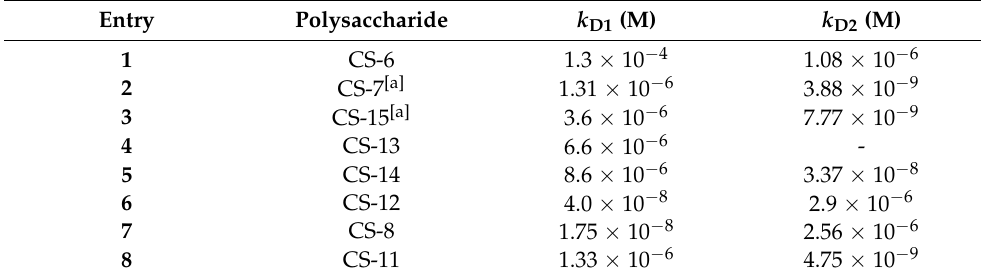
Table 4. Thermodynamic data of semi-synthetic CSs-FGF-2 interactions.